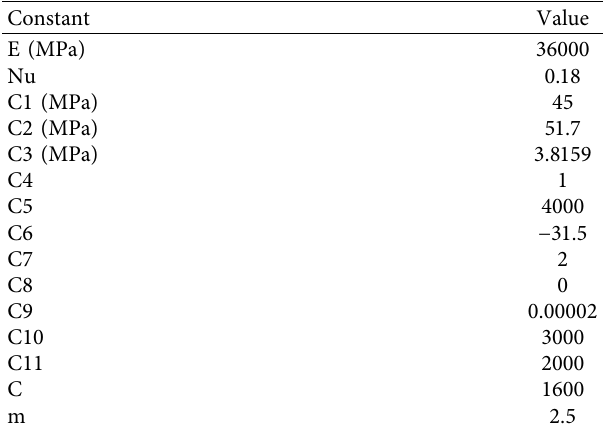
Table 2: Concrete coupled damage-plasticity microplane model inputs.